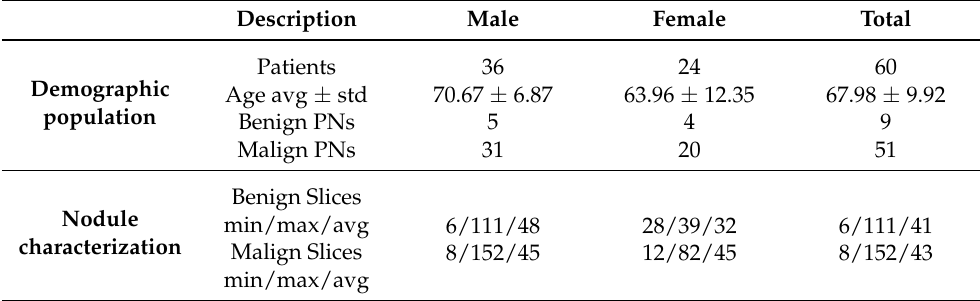
Table 2. Details of our